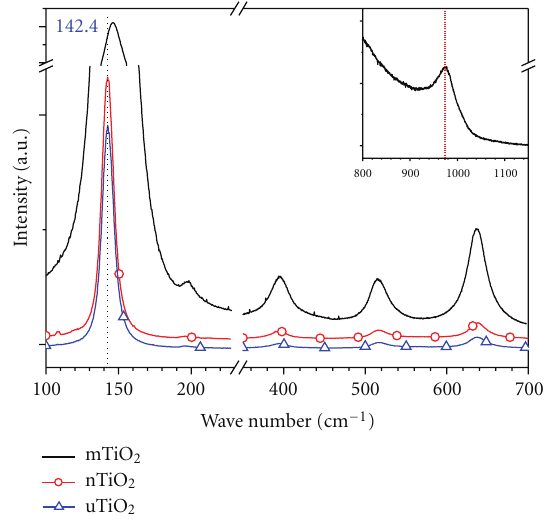
Figure 2: Raman spectra of the mTiO 2 , nTiO 2 , and uTiO 2